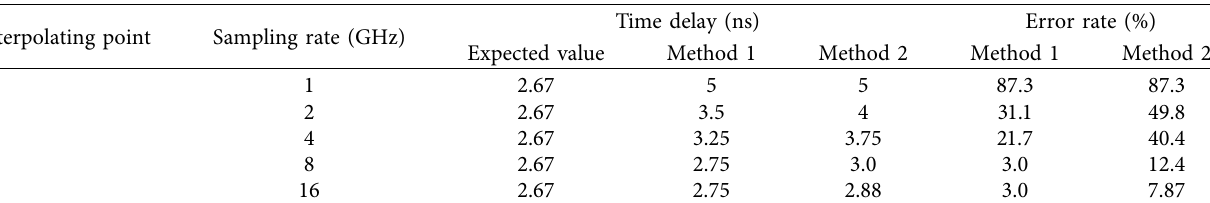
∗ “Method 1” represents the proposed fuzzy interpolation cross-correlation method and “Method 2” represents denotes the cubic spline interpolation cross- correlation method.